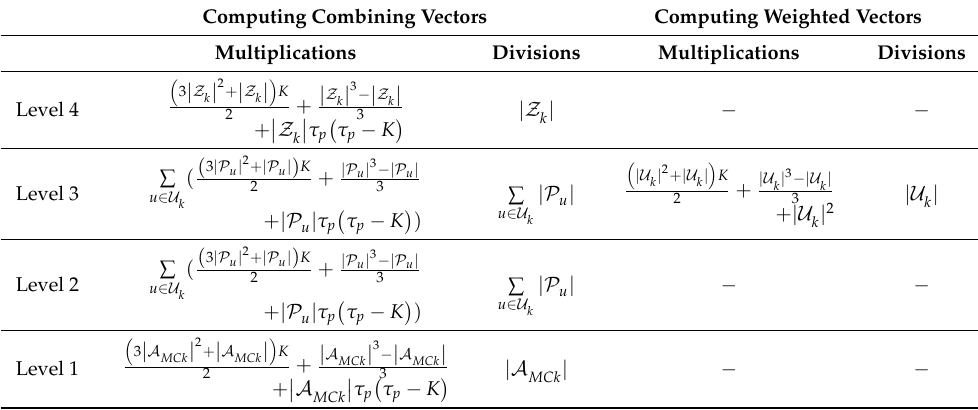
Table 3. Computational complexity of different level of cooperation per coherence block. Only complex multiplications and complex divisions are considered, and additions/subtractions are